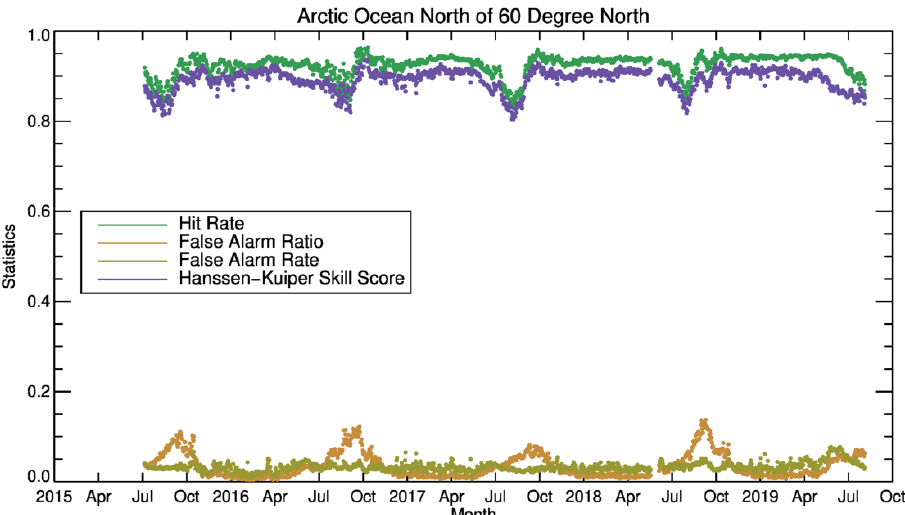
Figure 4. Daily Hit Rate, False Alarm Ratio, False Alarm Rate, and Hanssen-Kuiper Skill Score over the Arctic Ocean poleward of 60 ◦ North, when AMSR2 ice mask compared to IMS ice mask.